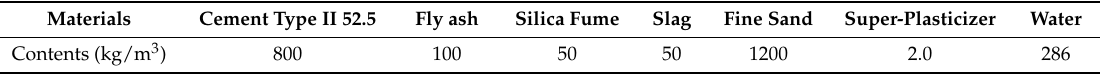
Table 3. Composition of TRM (textile reinforced mortar)